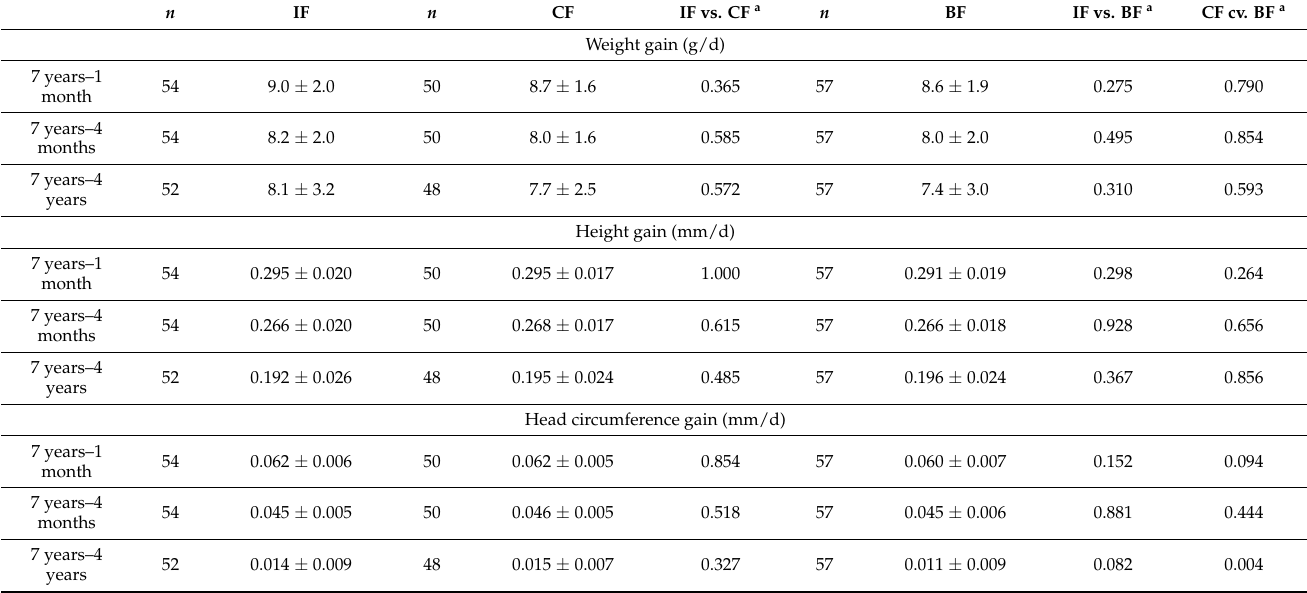
weight, length and BMI z-scores are shown in Supplemental Table S3. Table 3. Growth per day (mean ± SD) during the first seven years of life for the interventional for- mula group (IF), control formula group (CF) and formerly breastfed infants (BF).